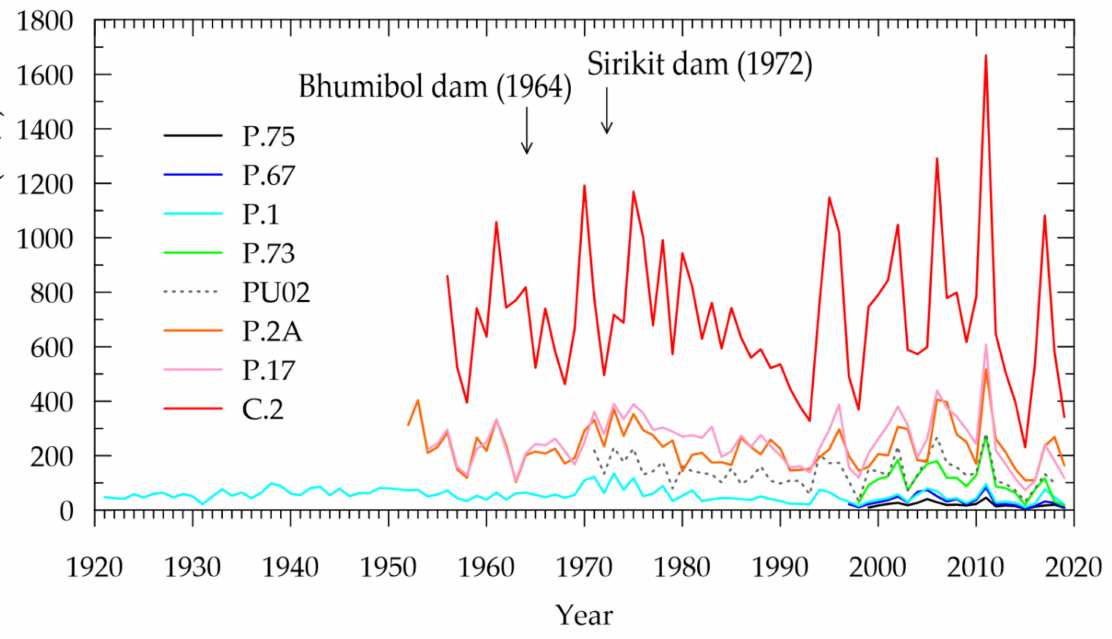
Figure 3. Time series of annual runoff at hydrological stations along the Ping River between 1921 and 2019. Table 1. Summary of available data and statistics of daily streamflow and suspended sediment at seven RID and EGAT hydrological stations on the Ping River and Station C.2 on the Chao Phraya River (Significance accepted at p -value < 0.10).